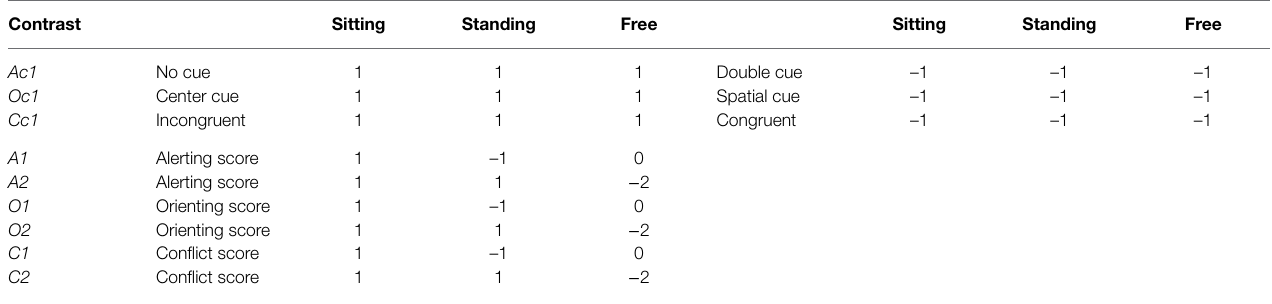
TABLE 1 | Sets of coefficients used for contrasts in the